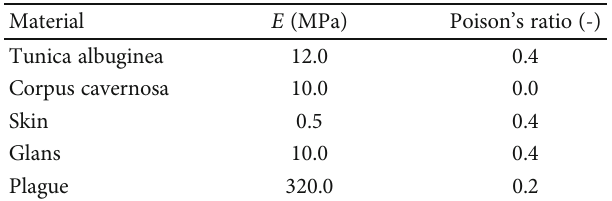
Figure 2: Mesh discretization of the penis model. Table 1: Material